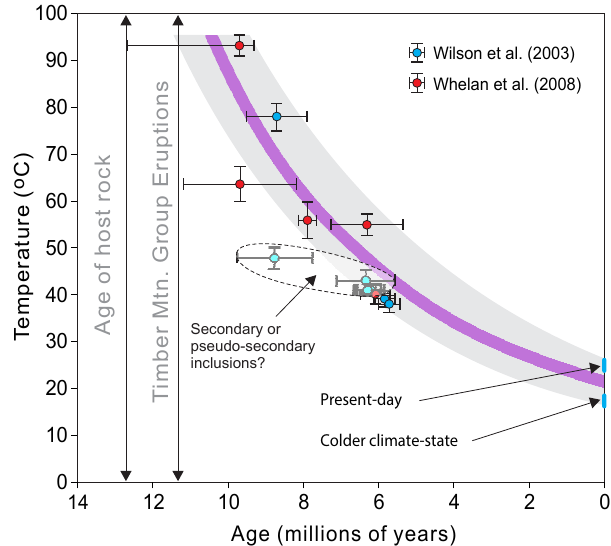
Figure 3. The proposed benchmark for thermal modeling at Yucca Mountain. The benchmark is constrained by fluid inclusion temper- atures paired with 235 U / 207 Pb ages (data from Wilson et al., 2003; Fig. 8 and Whelan et al., 2008; Tables 1 and 4) and the range of temperatures expected in the unsaturated zone of Yucca Mountain during different Pleistocene climate states (shown at zero